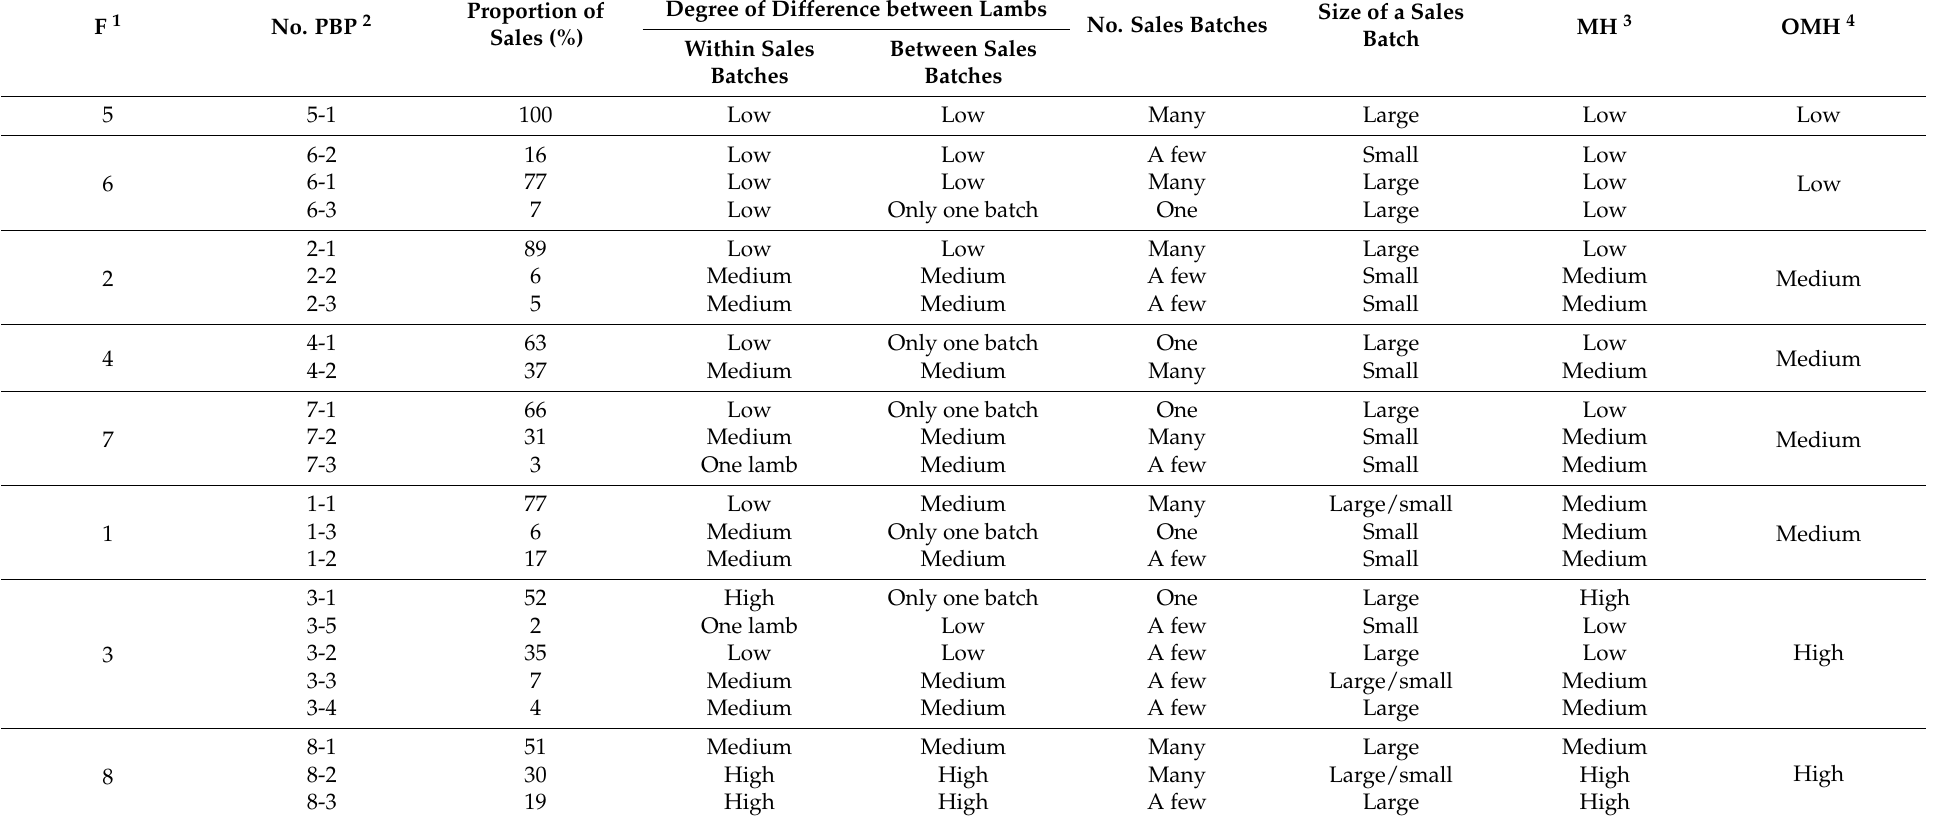
Table 4. Overall marketing heterogeneity for eight sheep meat farmers